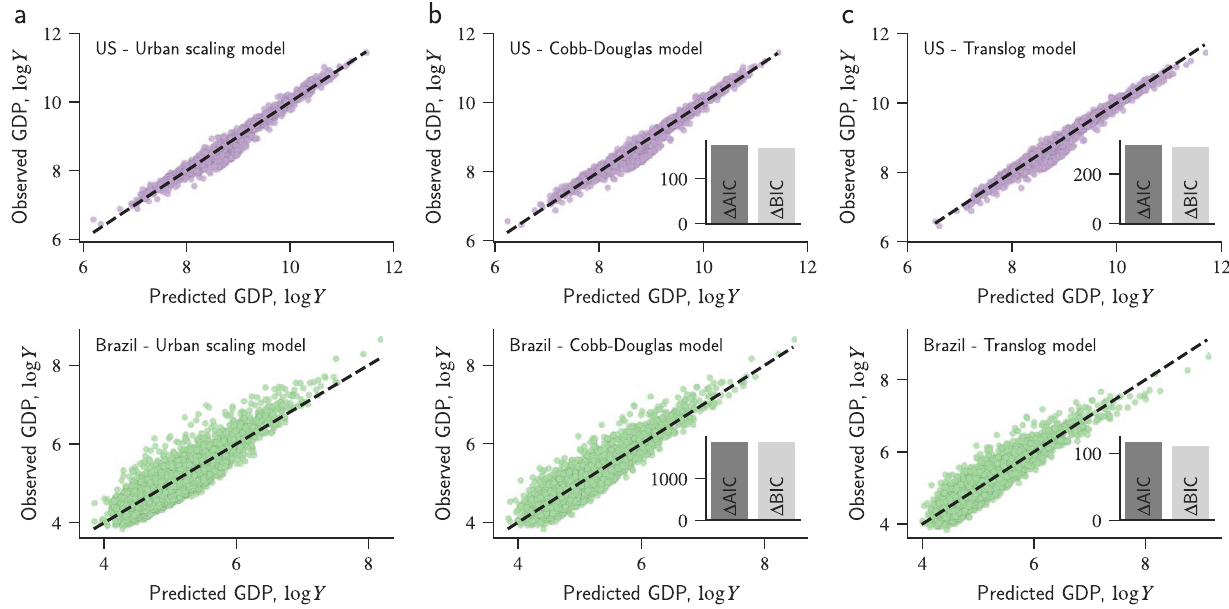
Figure 2. Urban scaling predictions of GDP and the improved descriptions based on the interplay between population and incoming commuters. Relation between the observed values of urban GDP and those predicted by ( a ) usual urban scaling (Eq. 1), ( b ) Cobb-Douglas model (Eq. 2), and ( c ) translog model (Eq. 3). All quantities are expressed in base-10 logarithmic scale and the dashed lines represent the 1:1 relationship. The upper plots (purple markers) show the results for US counties, and the lower ones (green markers) represent the values for Brazilian municipalities. The bar plot inserted in panel (b) shows the differences in the Akaike information criterion ( (cid:31) AIC ) and Bayesian information criterion ( (cid:31) BIC ) estimated between the Cobb-Douglas and urban scaling models. The large positive values of these quantities indicate that the Cobb-Douglas model significantly improves the description of urban GDP when compared with usual urban scaling. The inset in panel ( c ) shows the same quantities ( (cid:31) AIC and (cid:31) BIC ) calculated between the translog and the Cobb-Douglas models, where the large positive values indicate that the translog model further refines the goodness of